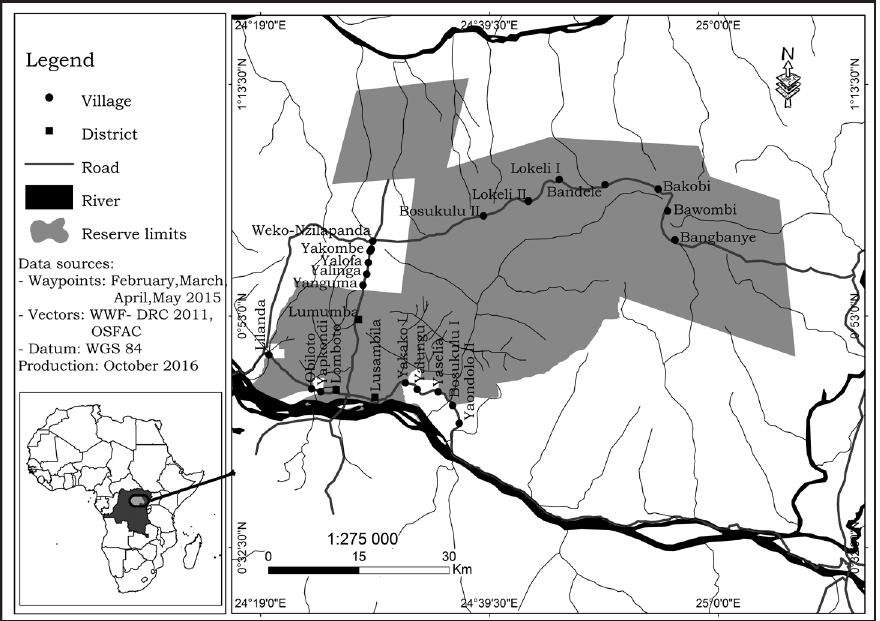
Map 1. Location of the sample villages in the study